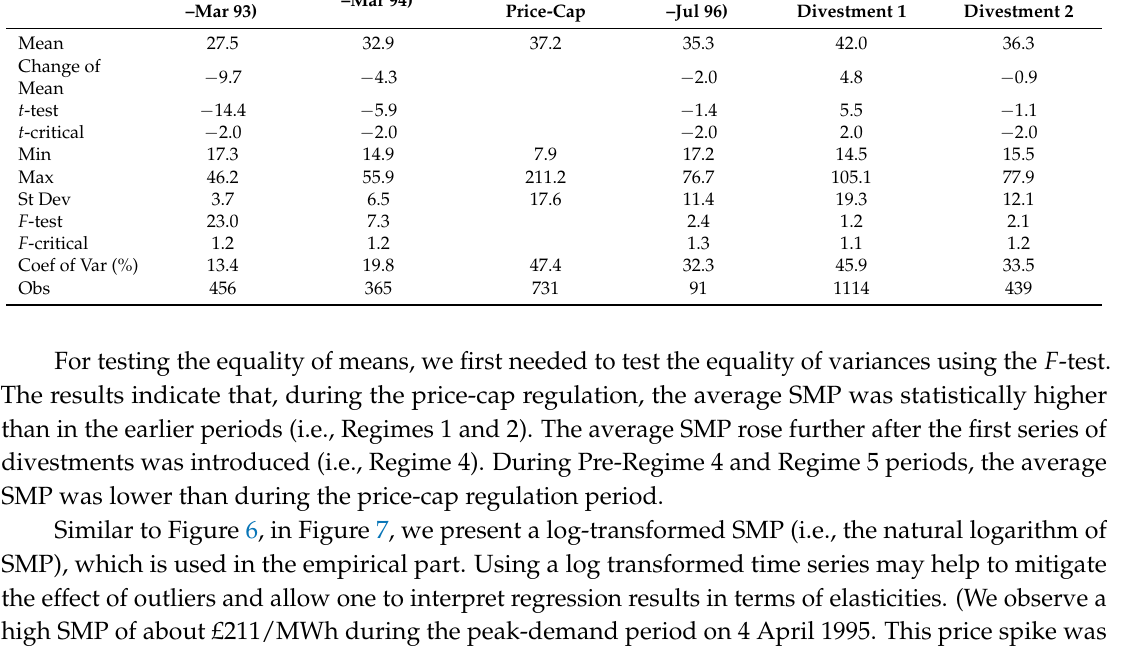
Table 1. Summary statistics for SMP (£/MWh) during the peak-demand period over trading days. SMP